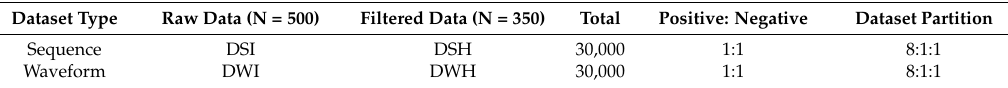
Table 2. Dataset implementation of DSI, DSH, DWI,